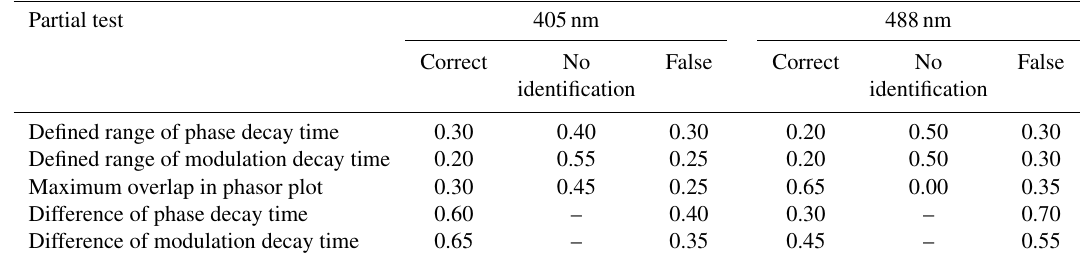
Difference of modulation decay time